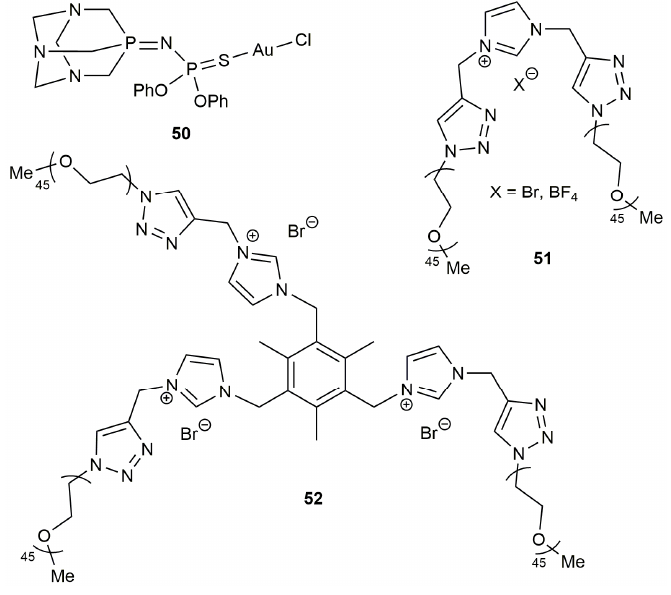
Figure 4. Structures of the gold(I) complex 50 and the PEG-tagged imidazolium salts 51-52 .